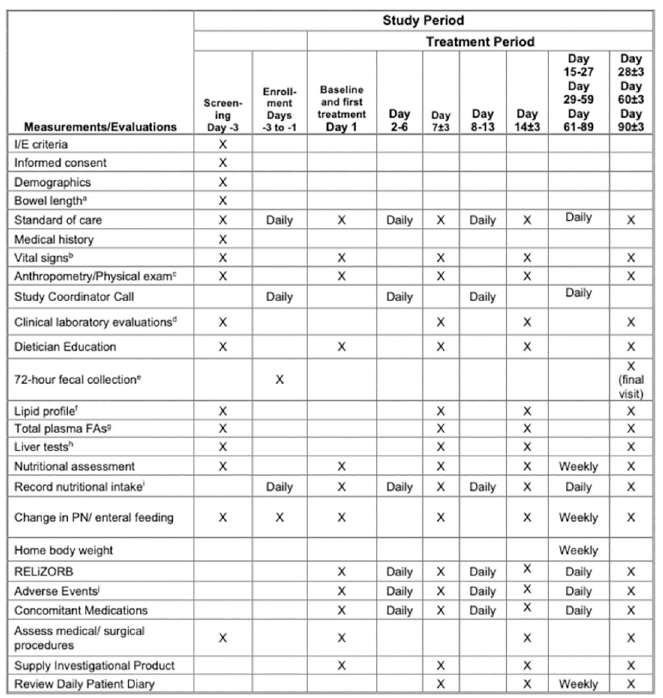
Fig 1. Schedule of enrolment, interventions, and assessments. I/E criteria = Inclusion and exclusion criteria. FAs = fatty acids. PN = Parenteral nutrition. a. Record known bowel length/type from last surgical resection or other measurement. b. Blood pressure, pulse rate, respiratory rate and temperature. c. Includes height or length, head circumference (for subjects < 36 months), and weight. If a physical examination or nutrition assessment was performed during the 3-day screening period, it will be used for the baseline assessment when available. d. Includes chemistry (including fat-soluble Vitamins A, D, E, and K), hematology, coagulation and C-reactive protein